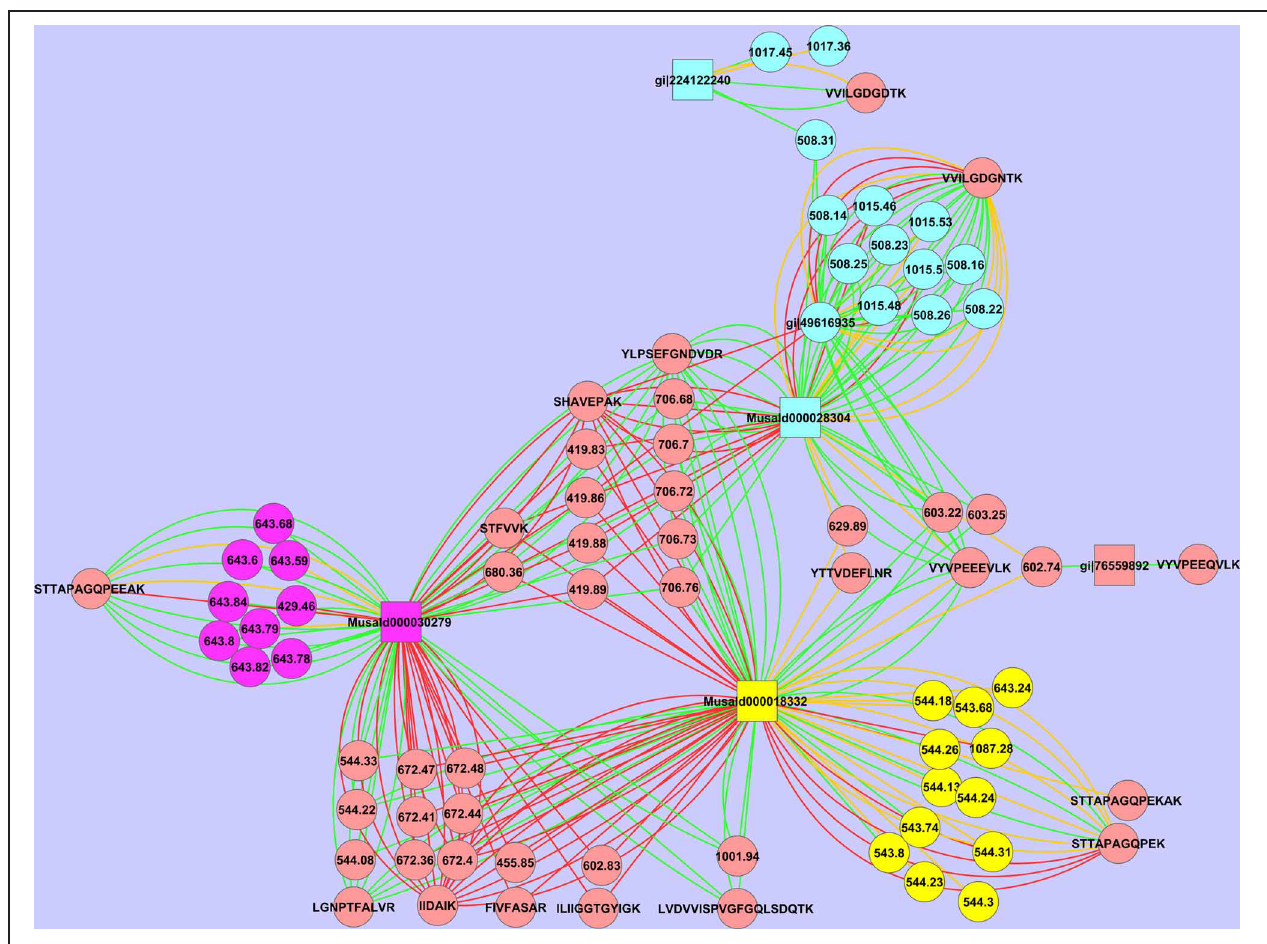
FIGURE 7 | Cytoscape representation of spot 18. Redundancy in M/Z values has not been removed. Interactions with an ion score ≥ 40 are displayed in green, < 40 in red. Proteins are represented as squares,